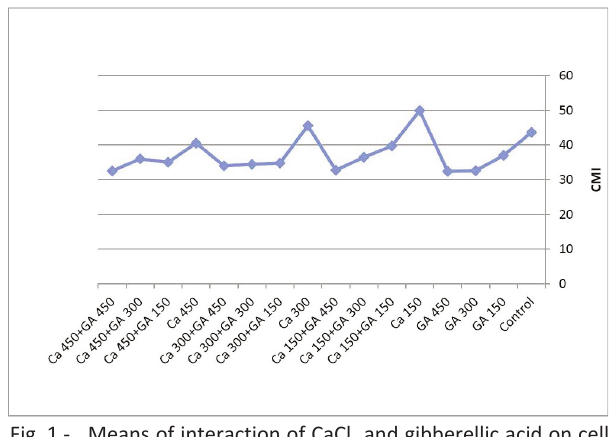
Fig. 1 - Means of interaction of CaCl membrane injury (CMI) of leaves of cut